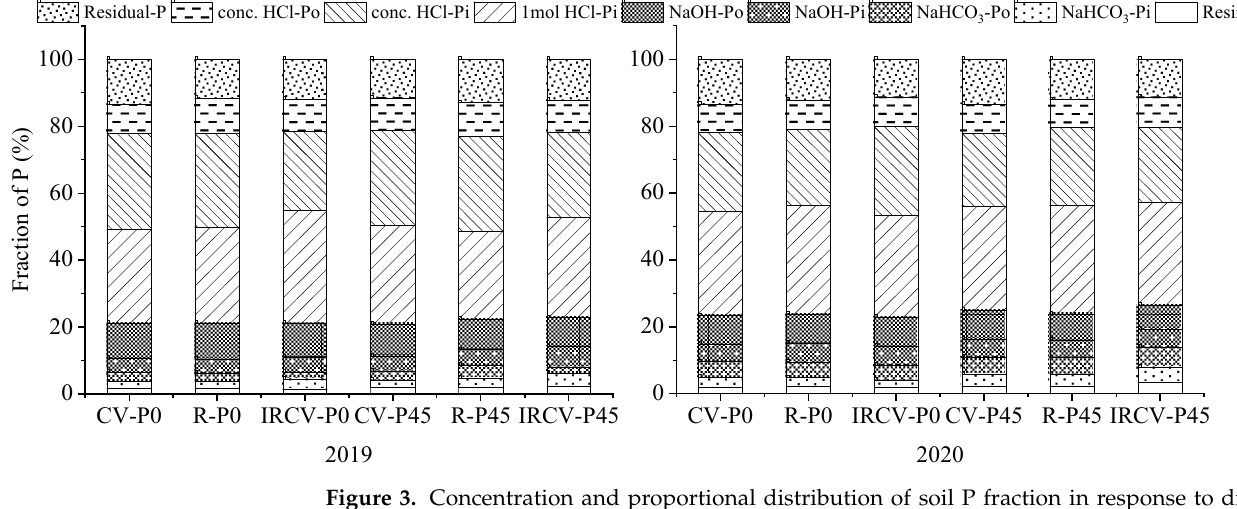
Figure 3. Concentration and proportional distribution of soil P fraction in response to different cropping patterns. Table 5. Multi-factor analysis of variance of soil P fractions in